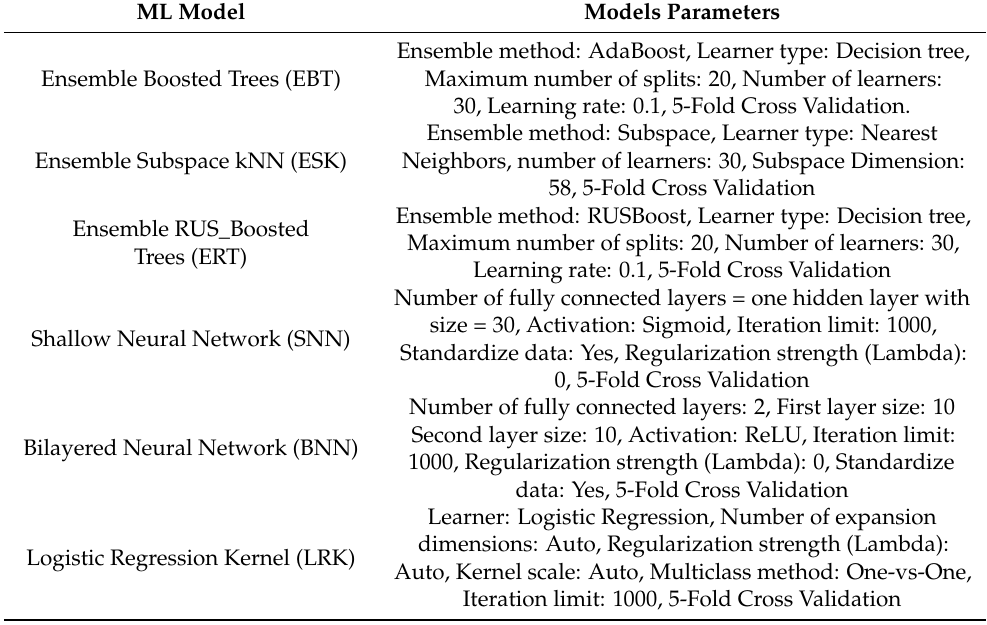
Table 5. Summary of System Development